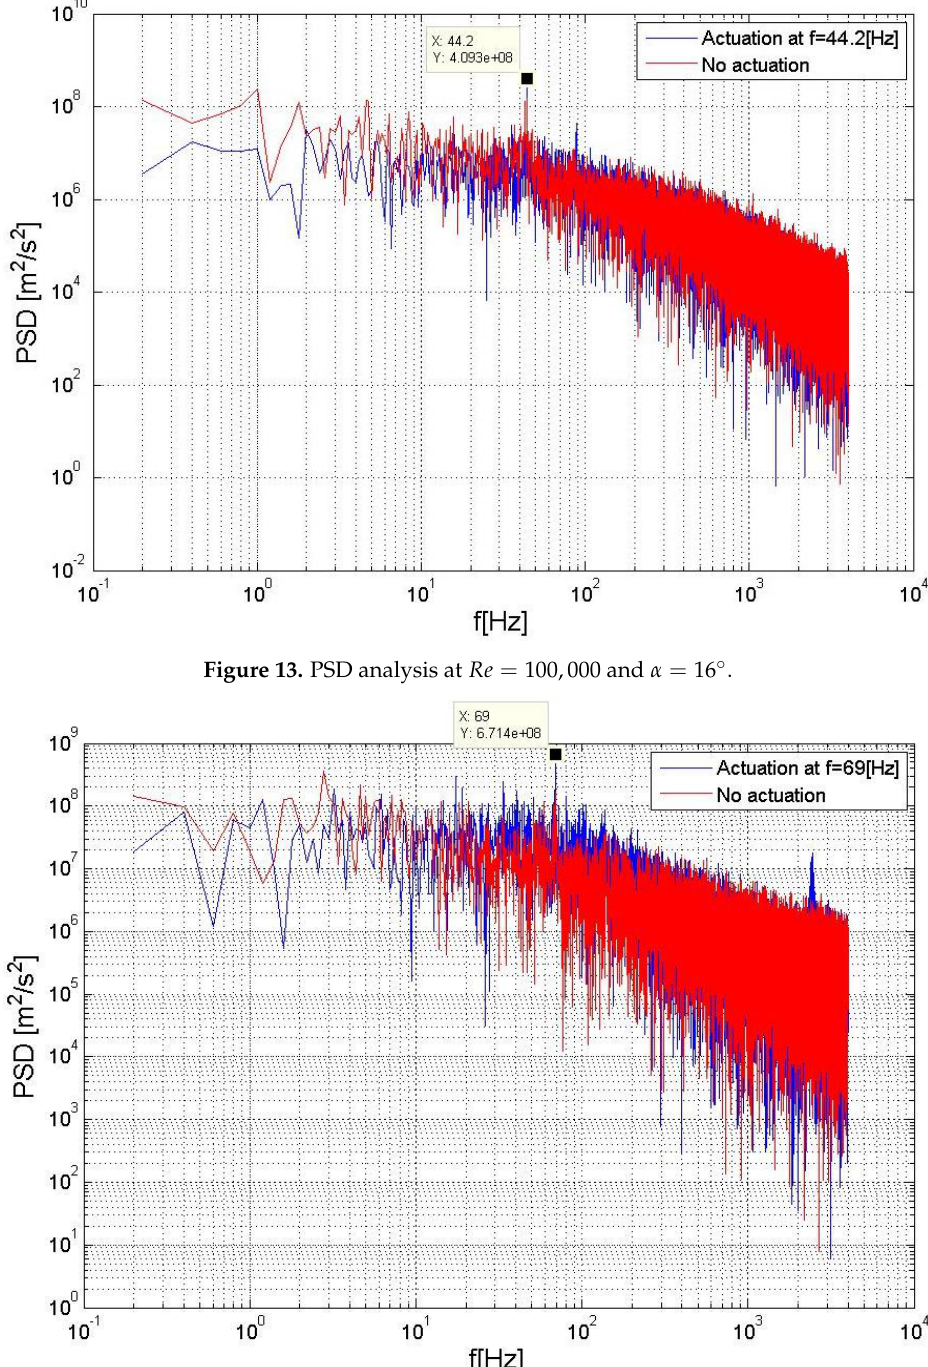
Figure 14. PSD analysis at Re = 200,000 and α = 24 ◦